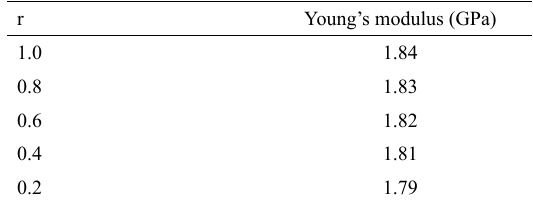
Table 6. Effective Young’s modulus as a function of the parameterized adhesion variable r , for the 89/10/1